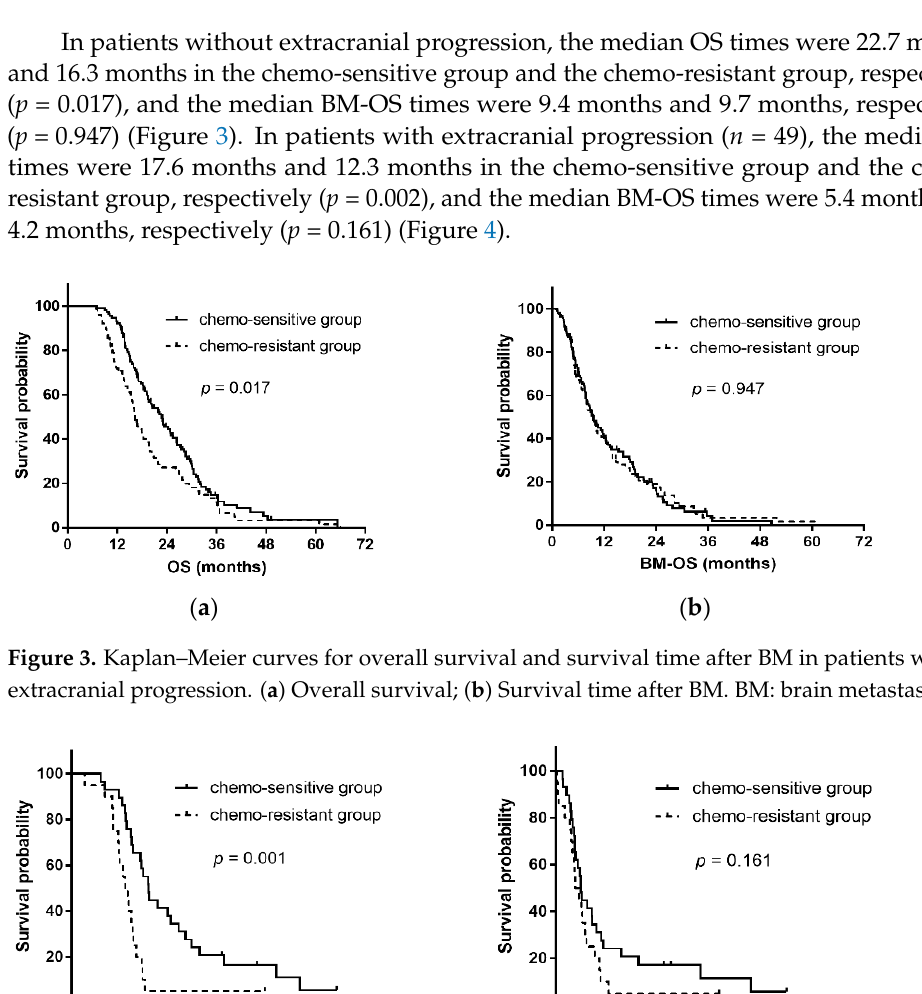
( b ) Figure 2. Kaplan–Meier curves for overall survival and survival time after BM in all patients be- tween two groups. ( a ) Overall survival; ( b ) Survival time after BM. BM: brain metastasis. In LD-SCLC patients ( n = 155), the median OS was 21.8 months, and the median BM- OS was 10.5 months. Between the chemo-sensitive group and the chemo-resistant group,